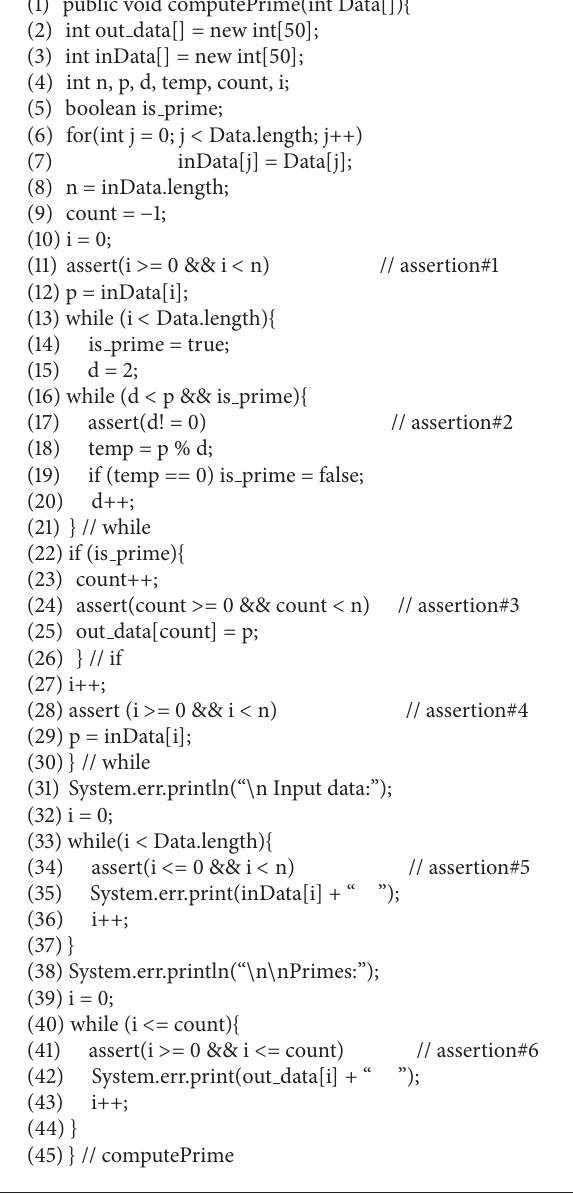
Algorithm 1: A sample Java method with